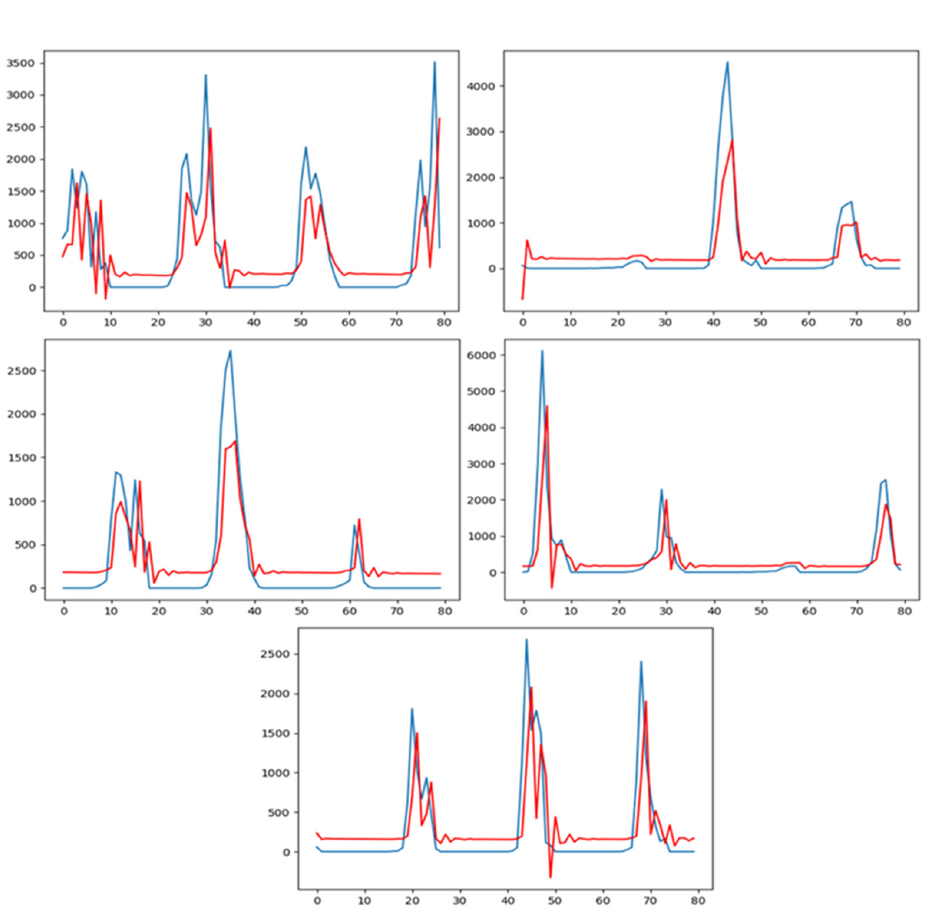
Figure 14. (blue) Original segment of BEE_OUT time series; (red) prediction for each fold (fivefold time-series split).